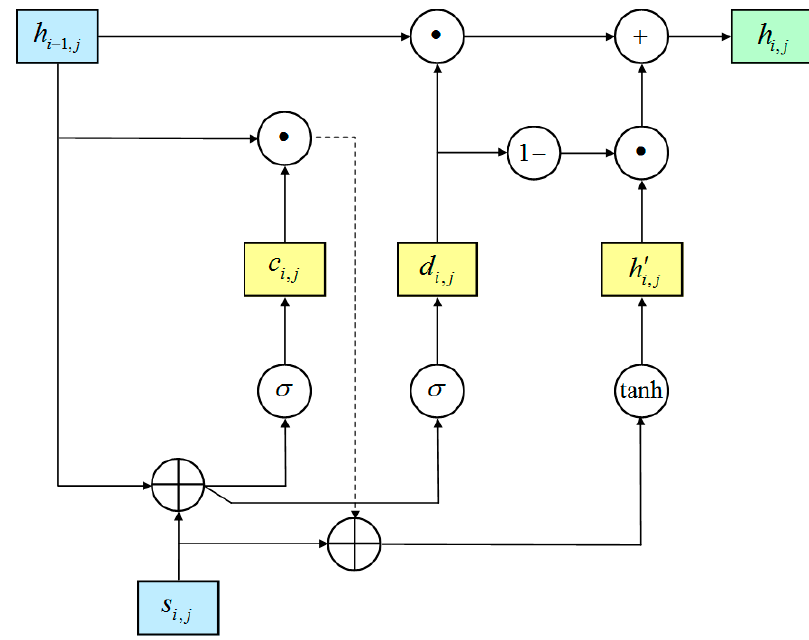
Figure 2. The structure of GRU.